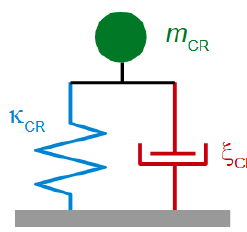
Figure 31. A lumped-element representation of a load giving rise to a coupled resonance. This mechanical circuit implicitly invokes the small-load approximation insofar, as the resonator has been drawn as a plate. It might also have been drawn as two large spheres, coupled to each other by another spring (Figure 1B). Had it been drawn as in Figure 1B, the solution to the full set of dynamical equations would have predicted anticrossing (as for the film resonance, Section 4.5.4). Anticrossing is not further discussed in the following. Coupled resonances caused by particles will usually be too broad to let anticrossing be visible.